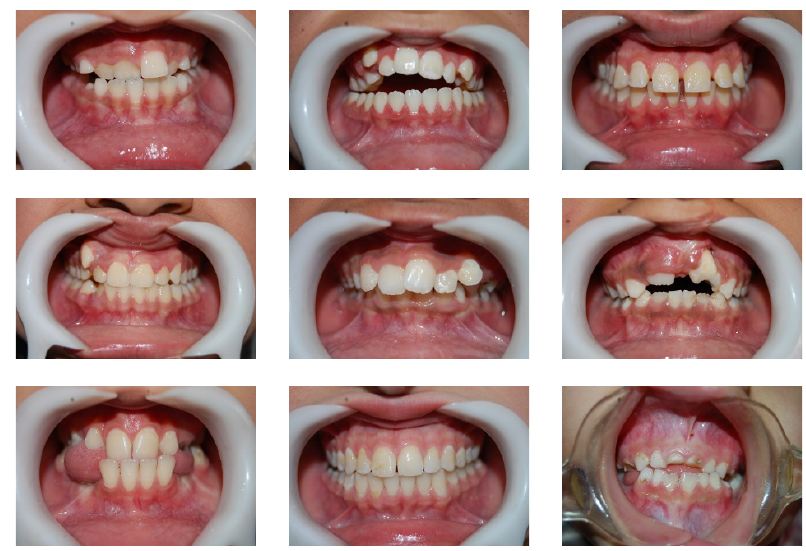
Figure 4. Sample of images collected in the database.